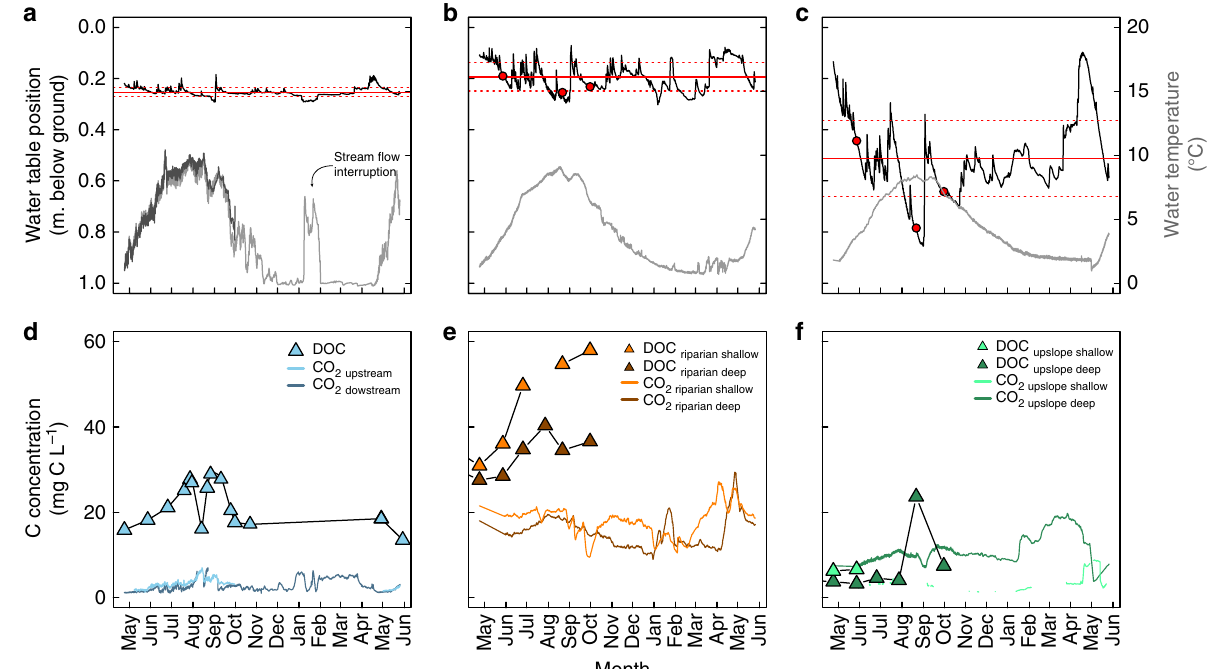
Fig. 4 Time series of hydro-climatic conditions and C concentrations across the transect. a – c Time series of water table position (black line) with its annual mean and standard deviation (full and dotted red lines, respectively) and the water temperature (grey line) in a the stream water, b riparian groundwater, and c upslope groundwater. The groundwater 14 C sampling occasions are identi fi ed by red circles. d – f Time series of CO 2 concentration and DOC concentration in the d stream water, e riparian groundwater, and f upslope groundwater. Time series are presented for the period from